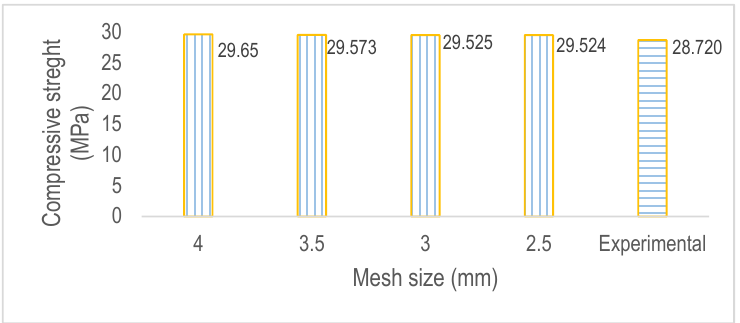
Figure 8. Modeling results vs. experimental value. Compressive strength. Table 9. Descriptive statistics.